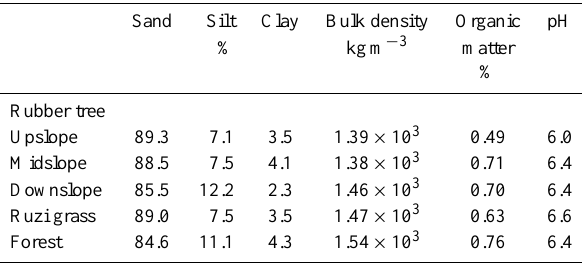
Table 1. Physical and chemical properties of the topsoil at the dif- ferent